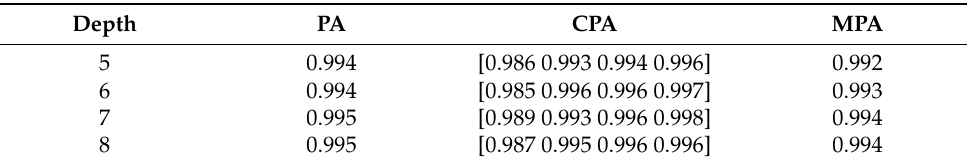
Table 4. Experimental results under different U-net